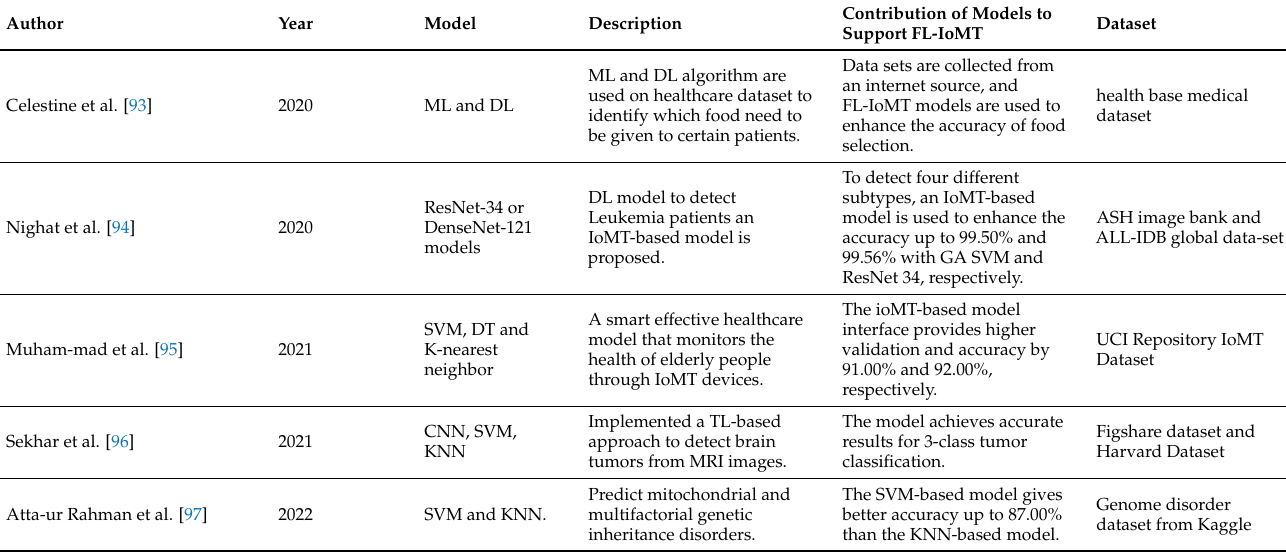
Table 7. Contribution of ML and DL models to support